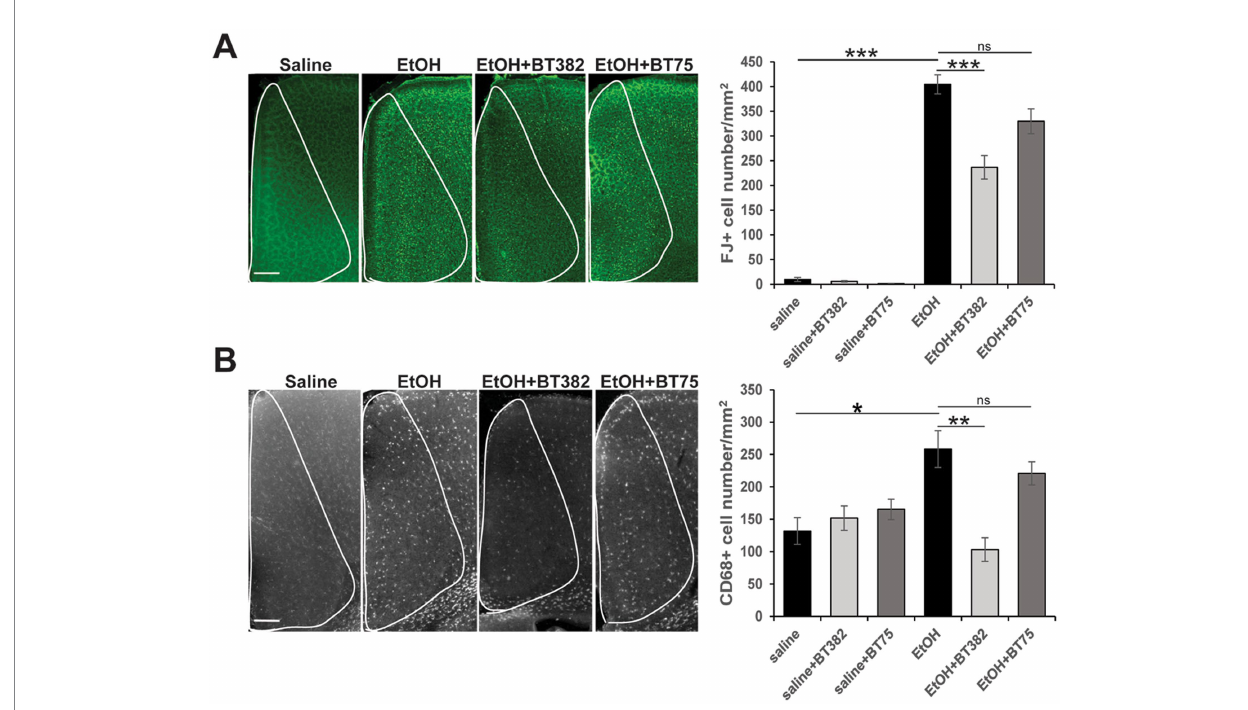
FIGURE 2 BT382 attenuated P7 ethanol-induced neurodegeneration. Mice were injected with saline/ethanol (EtOH) at P7, perfusion-fixed at P8 (20 h after injections), and the brain sections were stained with FJ (A) or immunofluorescence-stained using anti-CD68 antibody (B) . Images are representative brain sections in the cingulate cortex area (scale bar = 200 μ m), and the graphs show FJ+ cell densities (A) and CD68+ cell densities (B) in the cingulate cortex (encompassed by white lines). * p < 0.05, ** p < 0.01, *** p < 0.001 and ns not significant by a Tukey test after one-way ANOVA. n =